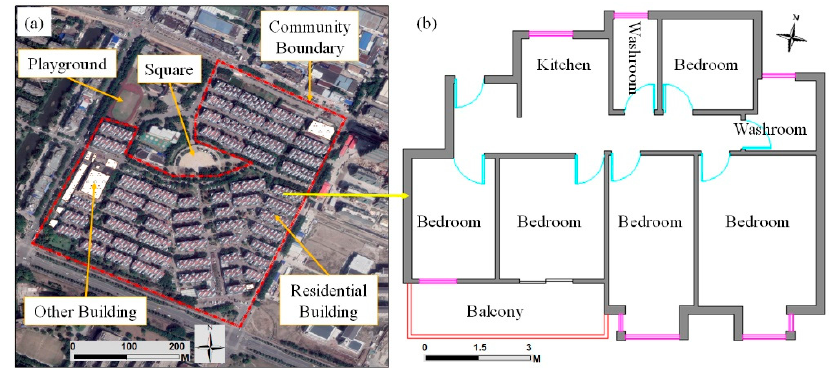
Figure 5. Living space of Qunyi Community.